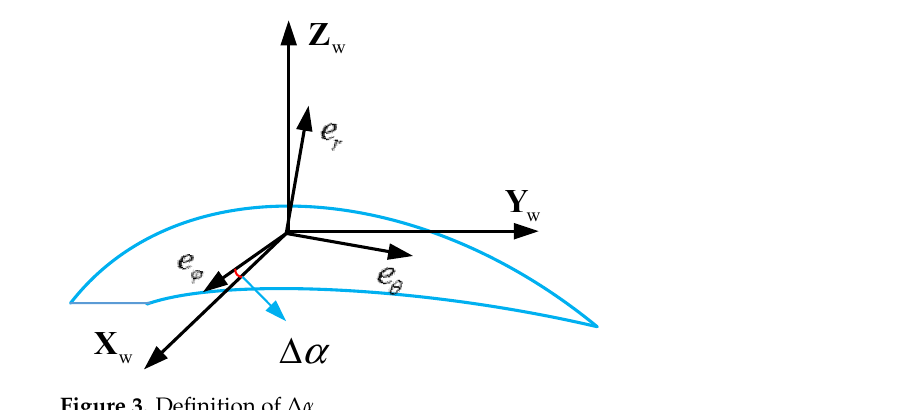
Figure 3. Definition of ∆ α .